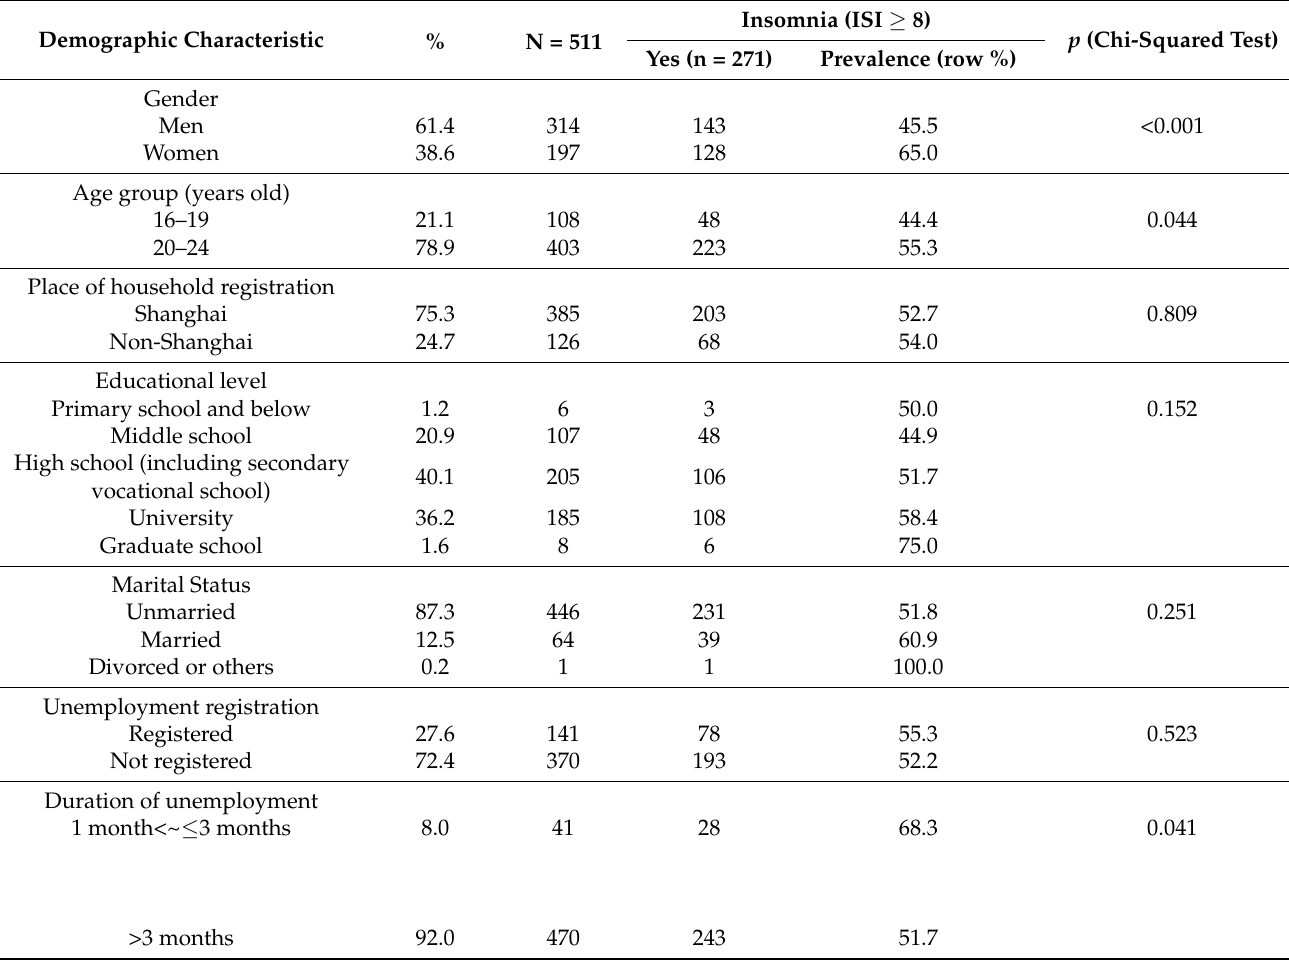
Table 1. Demographic information of participants and the results of chi-squared tests.